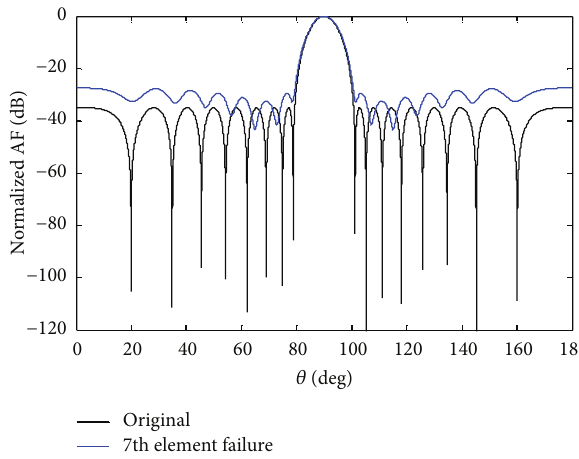
Figure 1: The original Chebyshev array and the 𝑤 7 sensor damage pattern.